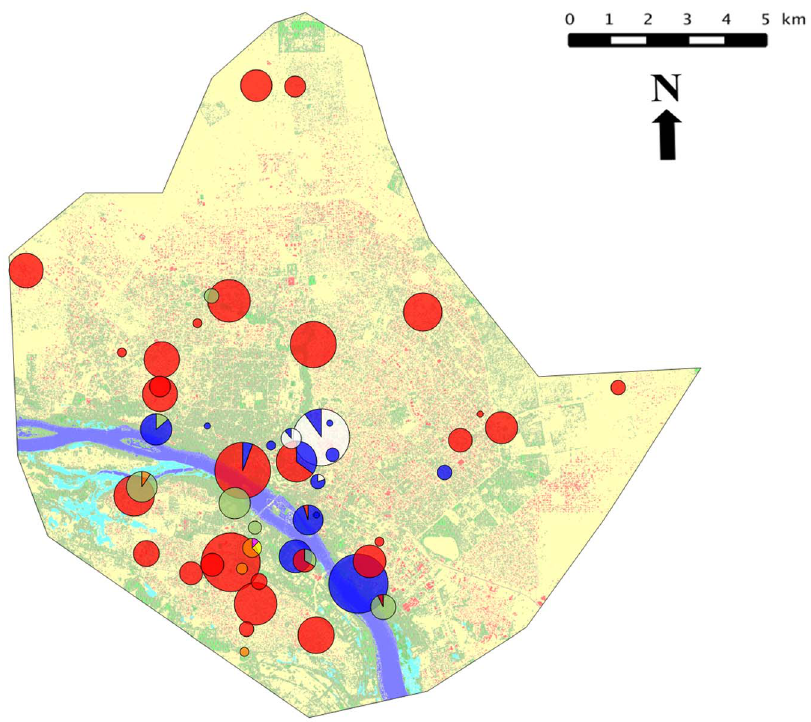
Figure 2. Spatial distribution of each of the seven species captured in Niamey. Each circle corresponds to one OP and/or SP trapping site (see Table 1 and Figure 1). The circle size is proportional to the total number of rodent captures. Each color stands for a given species: red for Mastomys natalensis , white for Mus musculus , blue for Rattus rattus , green for Arvicanthis niloticus , orange for Cricetomys gambianus , yellow for Taterillus gracilis and rose for Nannomys hausa